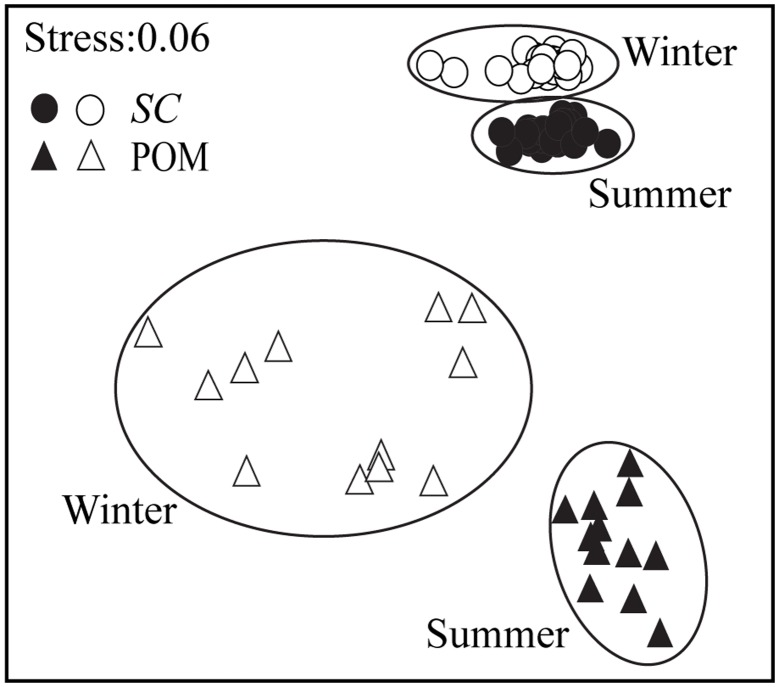
The MDS (Non-metric Multi-dimensional Scaling) ordination of fatty acid profiles of bivalve and particular organic matter in summer and winter.SC: Sinonovacula constricta. POM: particular organic matter. Samples in summer or winter are indicated with filled or open symbols.